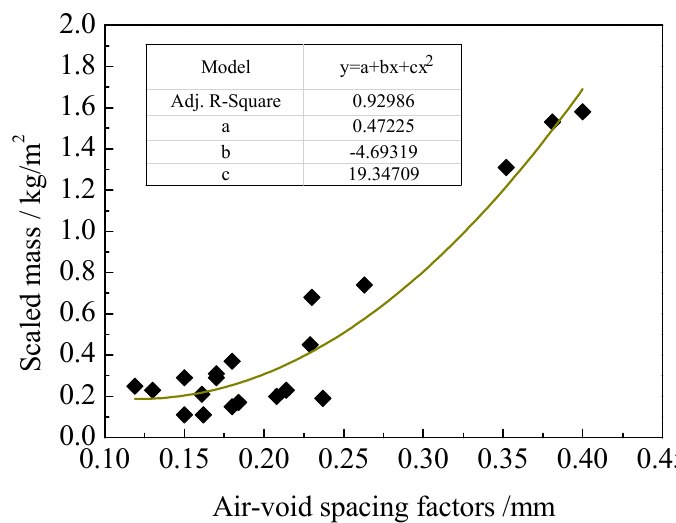
Figure 11. The relationship between the air-void spacing factor and the scaled mass of hardened concrete due to salt-frost.